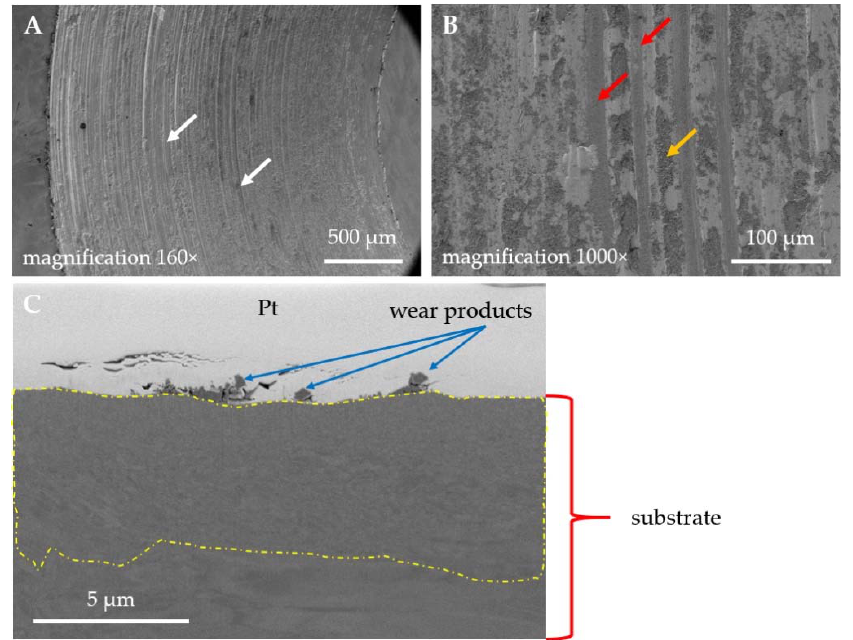
Figure 8. SEM micrographs of the wear tracks obtained for the uncoated 316L austenitic stainless steel (S1): ( A , B ) surface state of the wear track, ( C ) FIB-SEM cross-section of a wear track.